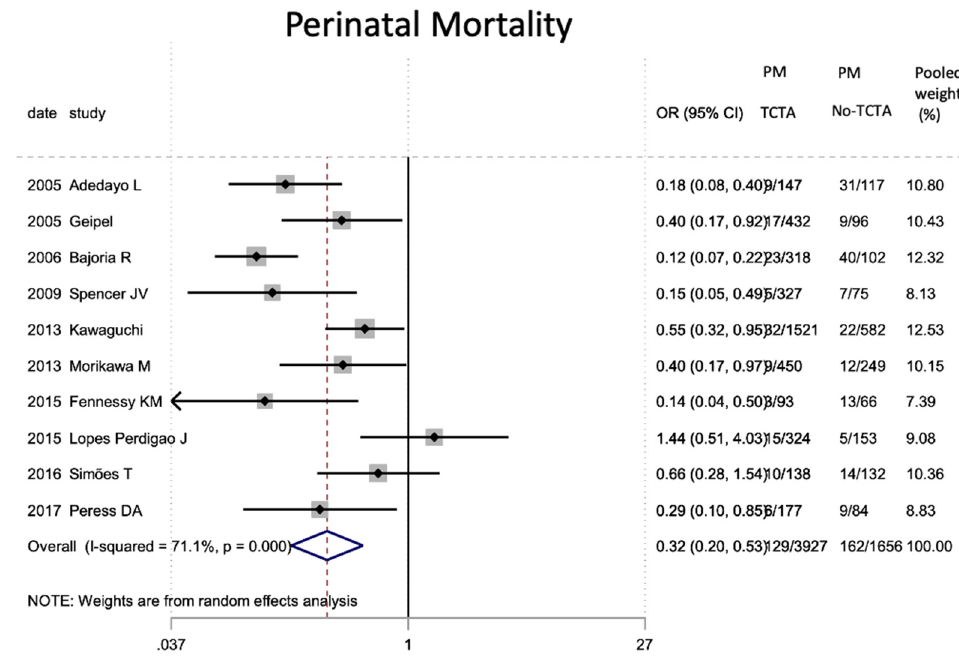
Figure 14. Results of the meta-analysis on the effect of chorionicity (TCTA vs no TCTA) on perinatal mortality. PM: perinatal mortal-ity; TCTA: trichorial-triamniotic, non-TCTA: non-trichorial- triamniotic. OR = odds ratio, CI = confidence interval.